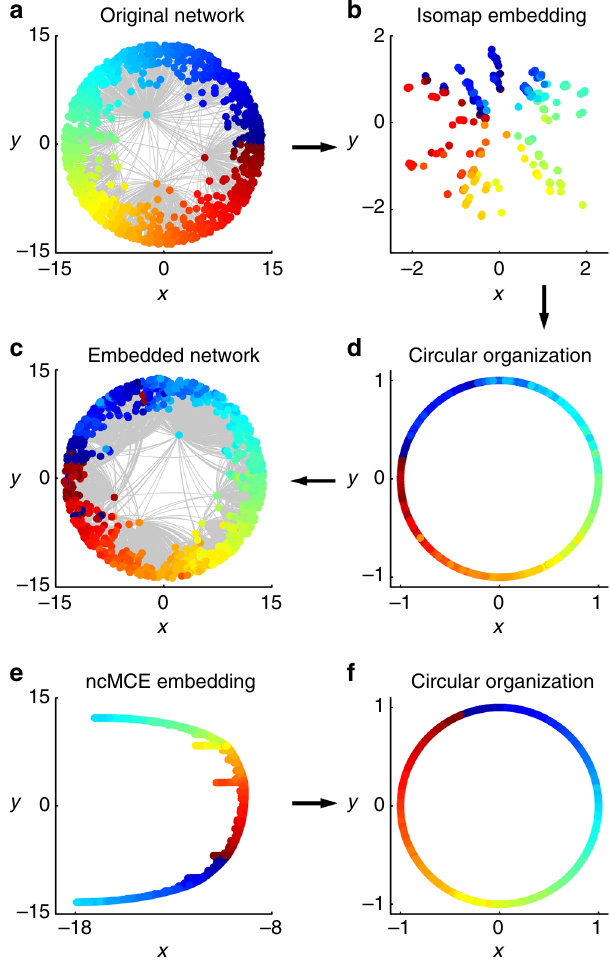
Fig. 1 Coalescent embedding. a We show the original synthetic network generated by the PSO model in the hyperbolic space. b The Isomap algorithm (ISO), which is the progenitor of manifold techniques, starting from the unweighted adjacency matrix offers an embedding of the network nodes that is organized according to a circular pattern that follows the angular coordinates of the original PSO model. We made different trials using other synthetic networks, and this circular pattern is mainly preserved if the kernel is centered or if the kernel is not centered and the fi rst dimension is neglected (see “ Methods ” section for details). This makes sense because the operation of kernel centering puts the origin of the reduced space at the center of the points in a multidimensional space and thus at the center of the manifold. Since the node points lie on the hyperbolic disk, the embedding places the origin approximatively at the center of the disk. d The nodes are projected over a circumference and adjusted equidistantly according to the step 3.2 of the algorithm described in “ Methods ” section. c The radial coordinates are given according to Eq. (4). e A different pattern is obtained for an algorithm named ncMCE. The circular pattern is linearized and the nodes are ordered along the second dimension of embedding according to their similarities (here the kernel is noncentered and the fi rst dimension of embedding should be neglected, see “ Methods ” section). f If we accommodate the node points on the circumference following the same ordering as the second dimension of embedding, we can again recover an unbroken circular pattern that resembles the angular coordinates of the original PSO